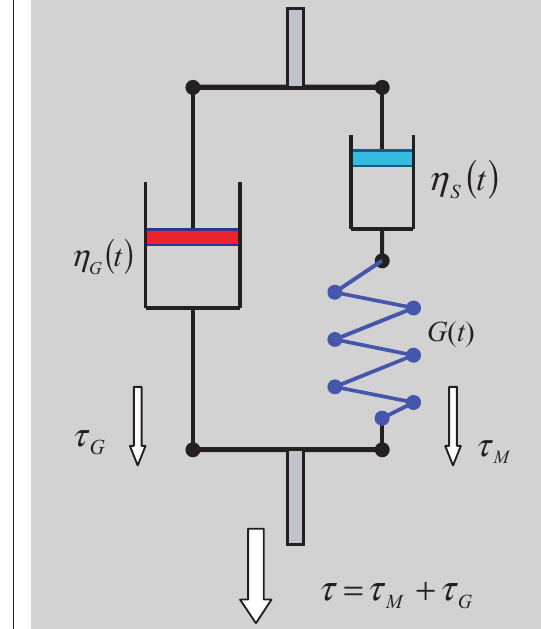
Figure 3: Rheological model of the gels structure